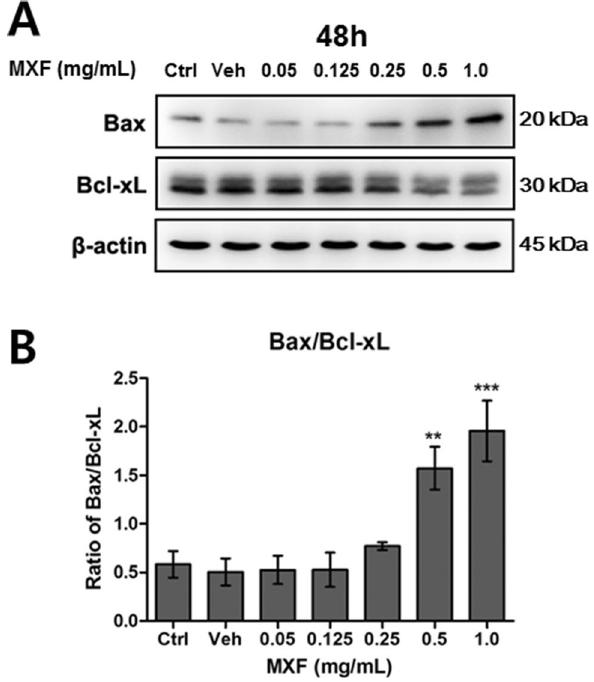
Figure 9. Bax/Bcl-xL ratio change by MXF exposure in HCECs. Pro-apoptotic Bax increased after MXF exposure, while anti-apoptotic Bcl-xL decreased. MXF exposure also increased Bax/Bcl-xL ratio accordingly in a dose-dependent manner. Note that only the bands at the adequate molecular weights were shown here. Full length gel and blots are included in the supplementary information. Ctrl: no treated normal control. Veh: 0.5% DMSO. * p < 0.05; ** p <